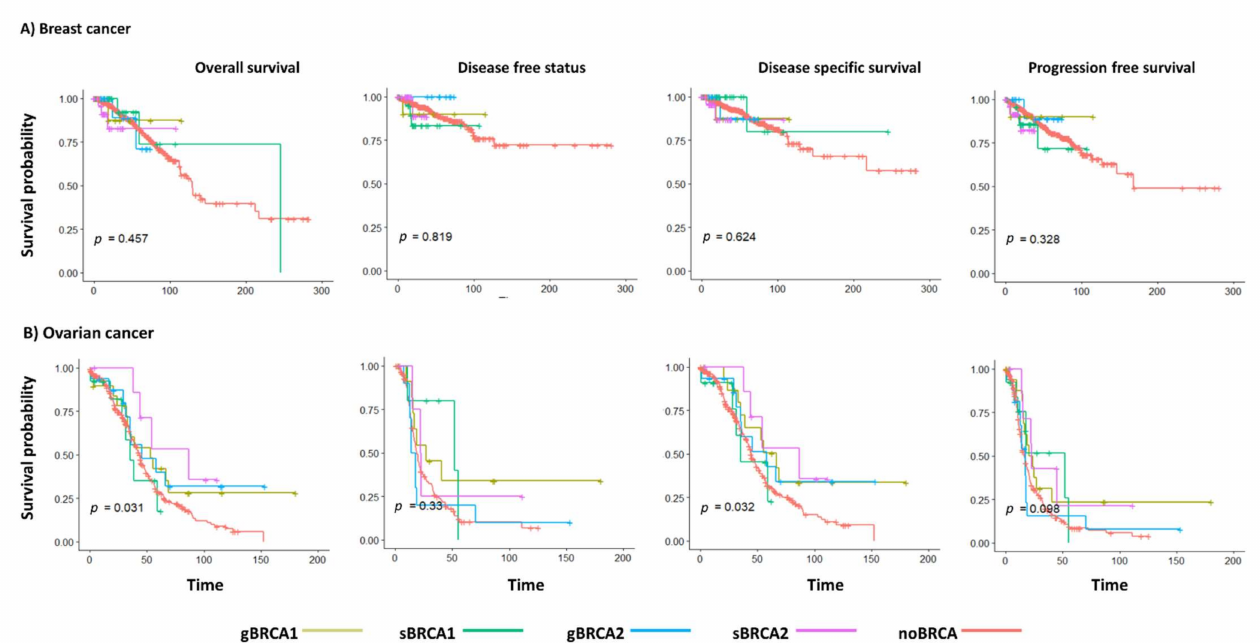
Figure 9. Survival associated with BRCA1 and BRCA2 mutations in the breast ( A ) and ovarian cancers ( B ). Significance was calculated using a Cox proportional hazards regression